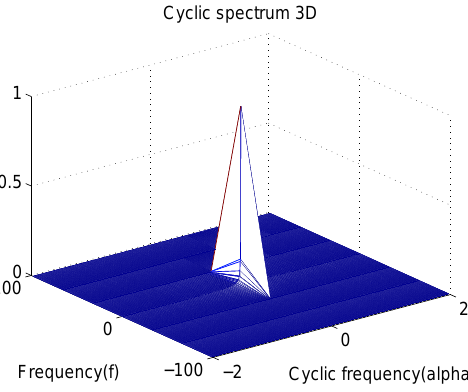
Figure 1. Spectral correlation function (SCF) of the second-order cyclostationary signal B ( t ) in (8), where noise and subject movement interferences are